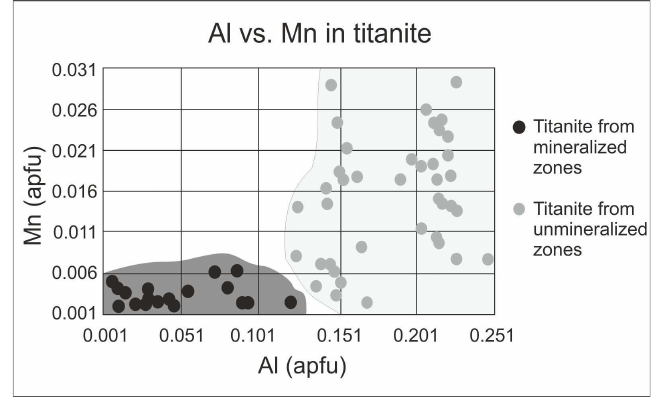
Figure 6. Al vs. Mn content of titanite from mineralized and unmineralized zones. Different fields can be clearly assigned.